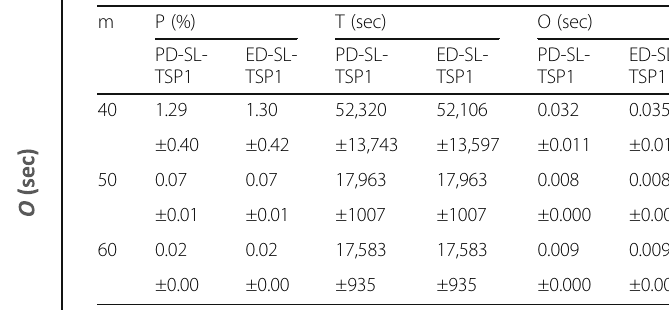
Table 9 Genome workload: effect of m on P , T , and O